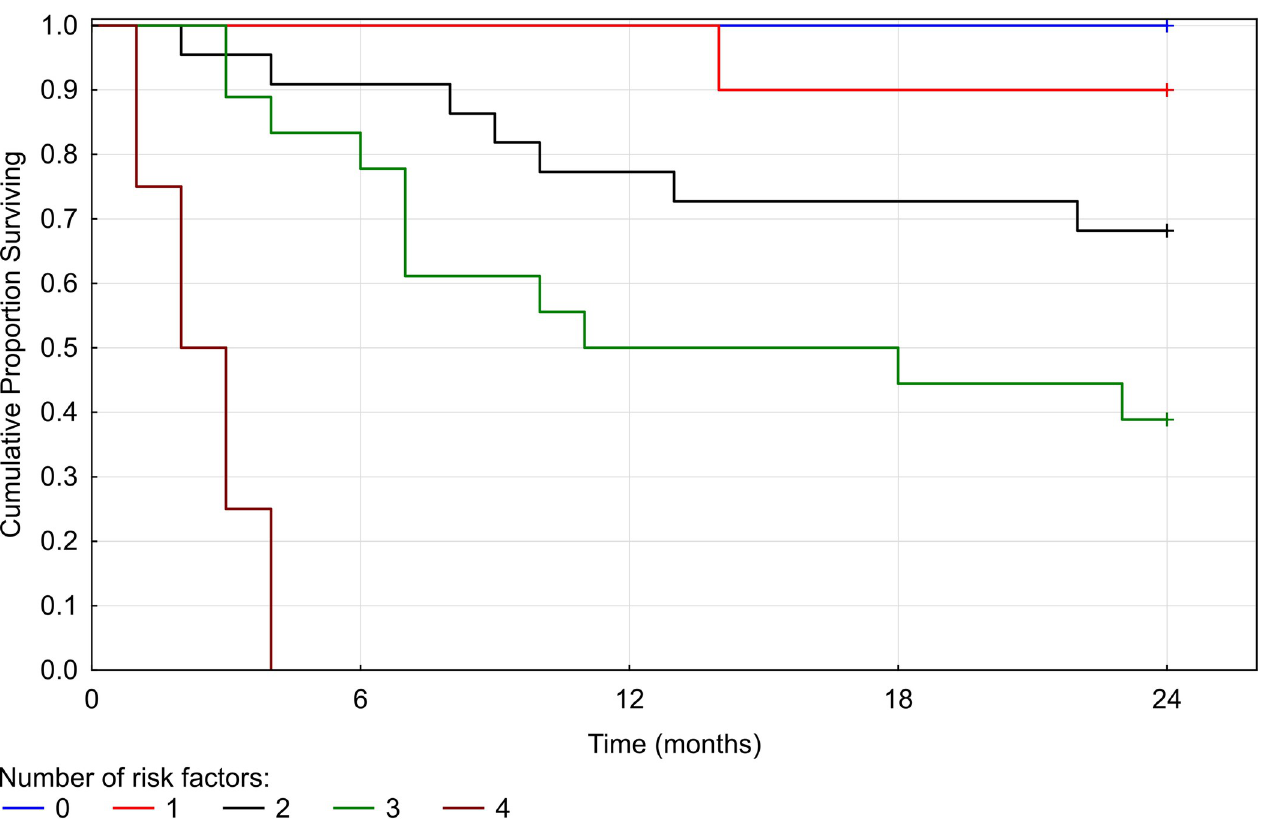
Fig 2. Relapse free interval—relation to the number of positive biomarkers. Fig 2 shows five Kaplan-Meier curves that correspond to the number of positive biomarkers (0–4) defined by the multivariate analysis (i.e. age at clinical onset, EDSS at time of therapy initiation, IL2:IL6 CSF, IL-2 CSF, CHI3L2 CSF). RFI becomes shorter with every added positive biomarker. In our cohort, none of the patients tested positive for all five biomarkers.